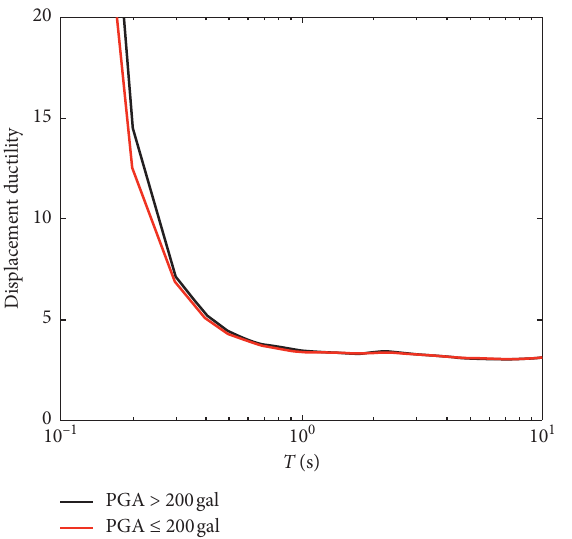
Figure 12: Effect of PGA on the variation of mean constant- strength ductility spectra.